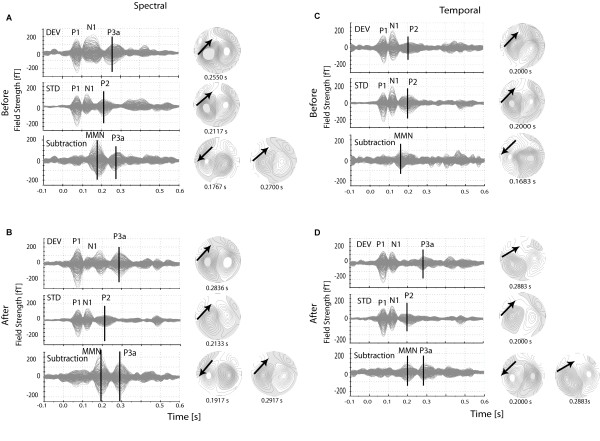
Single subject magnetic field responses. Overlay of the MEG channels for to the deviant tone (first row in each plot), standard tone (middle row) and subtracted waveform (bottom row), and the corresponding magnetic field maps for the response components marked with vertical lines on the plots. (A) Magnetic response data in SC before training (Before); (B) Magnetic response data in SC immediately after the training (After); (C) Magnetic response data in TC before training (Before); (D) Magnetic response data in TC immediately after the training (After).